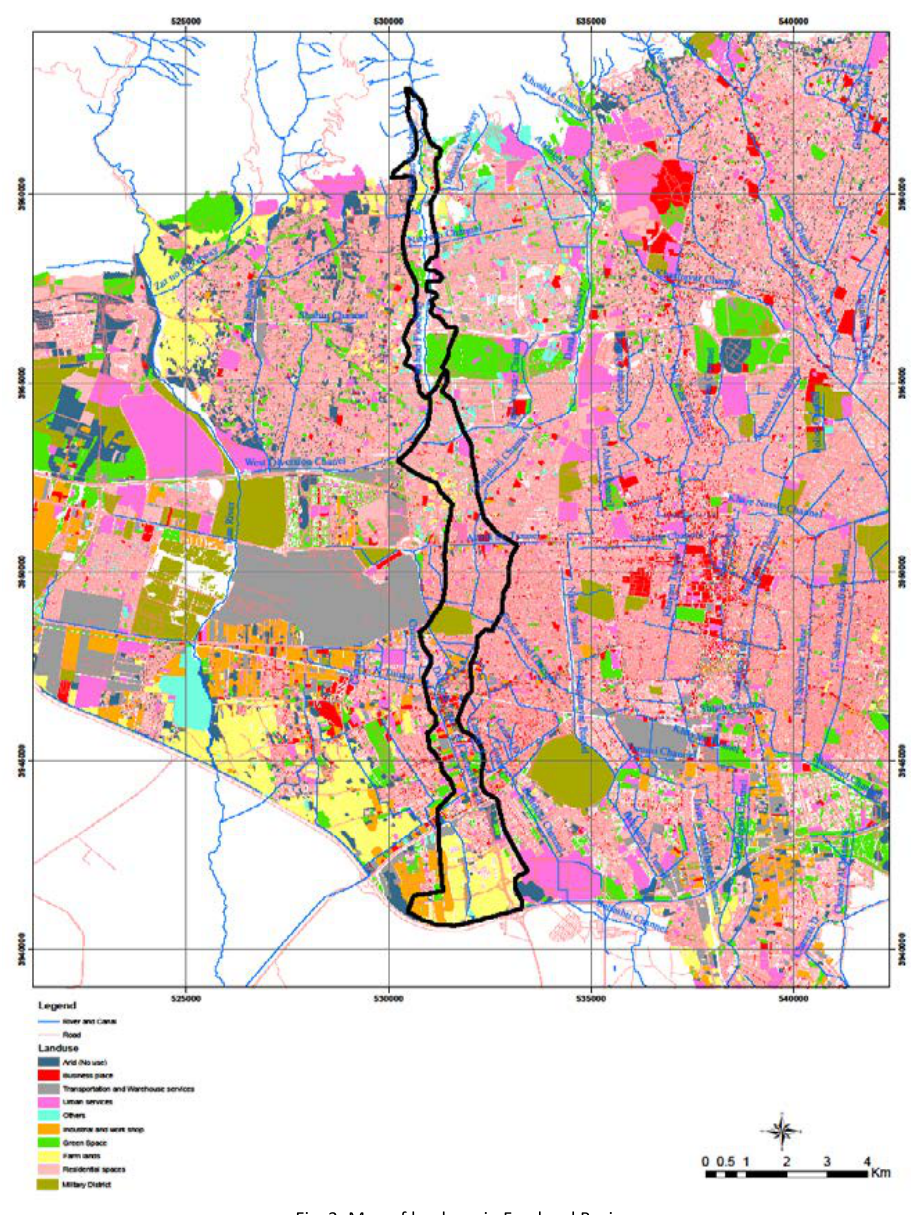
Fig. 3: Map of land use in Farahzad Basin